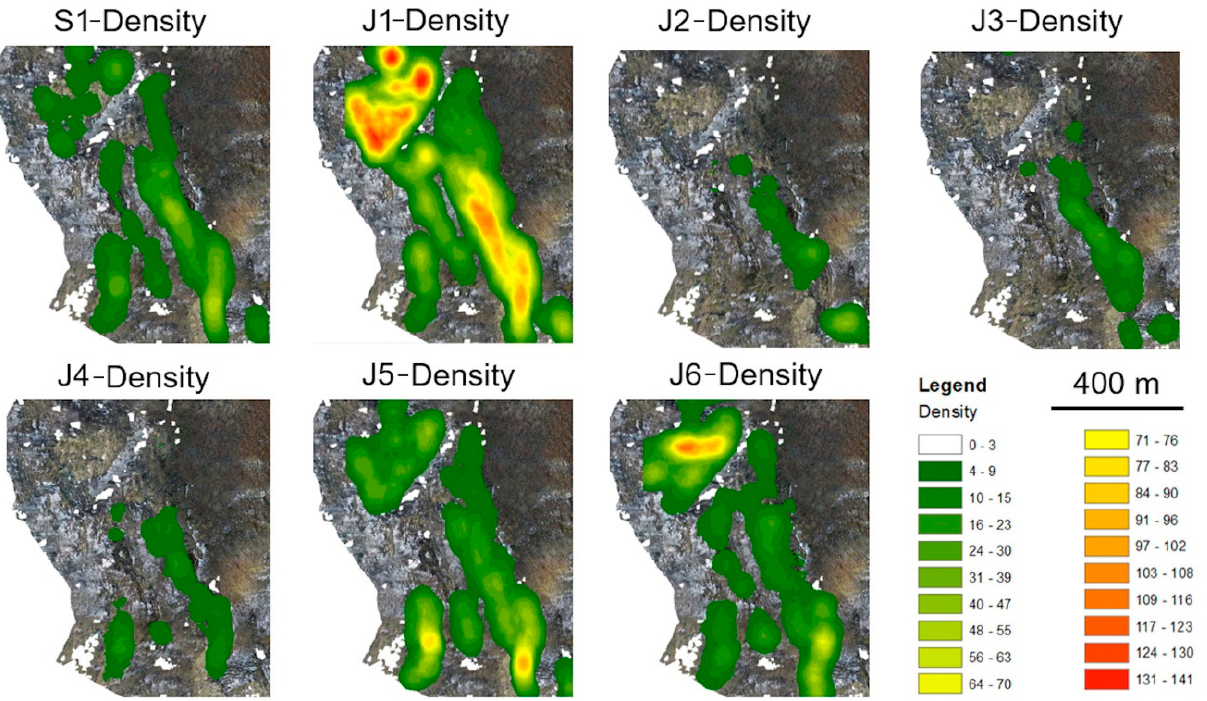
Figure 9. Orthophotos of the study area with indication of fracture density distribution for every identified discontinuity set.